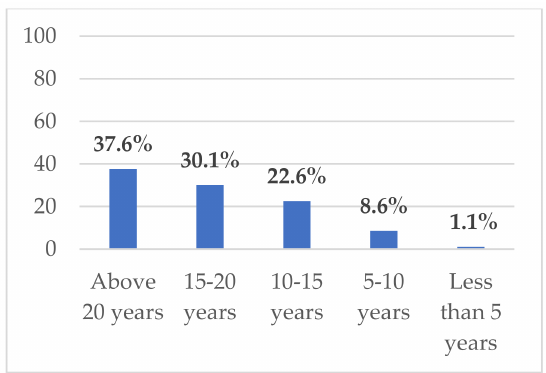
Figure 5. Years of operation in the construction industry.